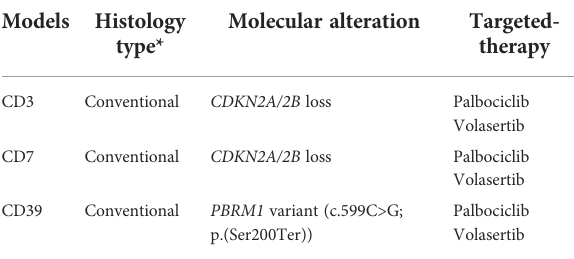
TABLE 1 Histopathological and molecular features of the three selected PDX